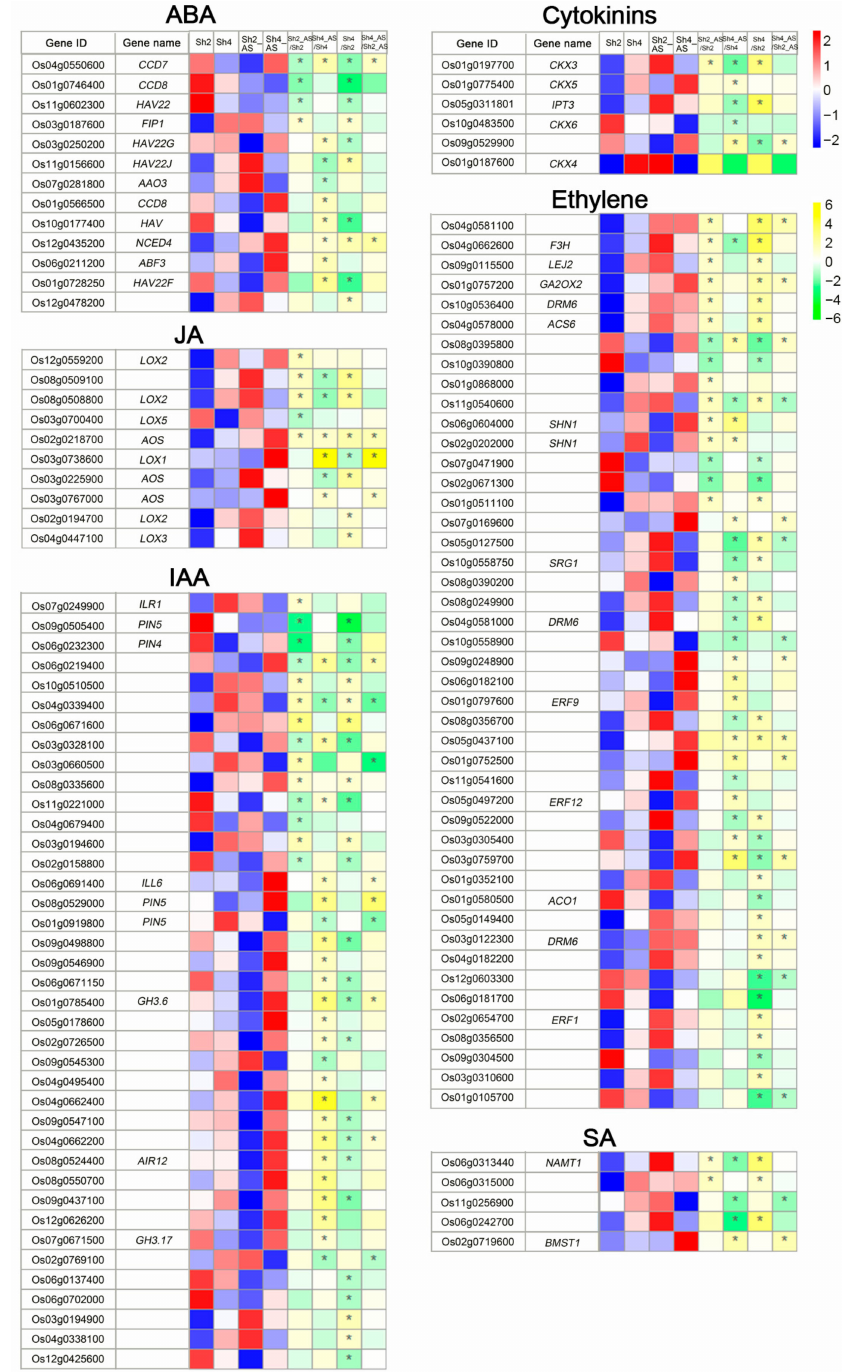
Figure 7. Expression profiles of genes related to phytohormones in shoots between 9311-2x and 9311-4x rice plants under mock and high pH conditions. Heatmap of differentially expressed genes (DEGs) analyzed using MapMan software. Yellow indicates genes expression levels (read_counts per million with log2 value). White indicates the fold change (log2 value) of DEGs. * p <